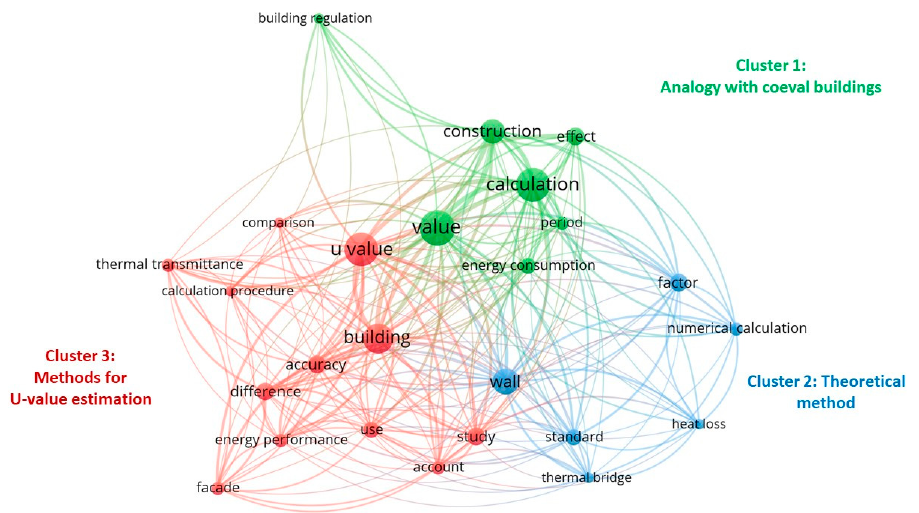
Figure 7. Co-occurrence network of keywords on the topic “ thermal transmittance estimation of build- ing *” (source: authors’ elaboration using VOSviewer, based on Scopus data).